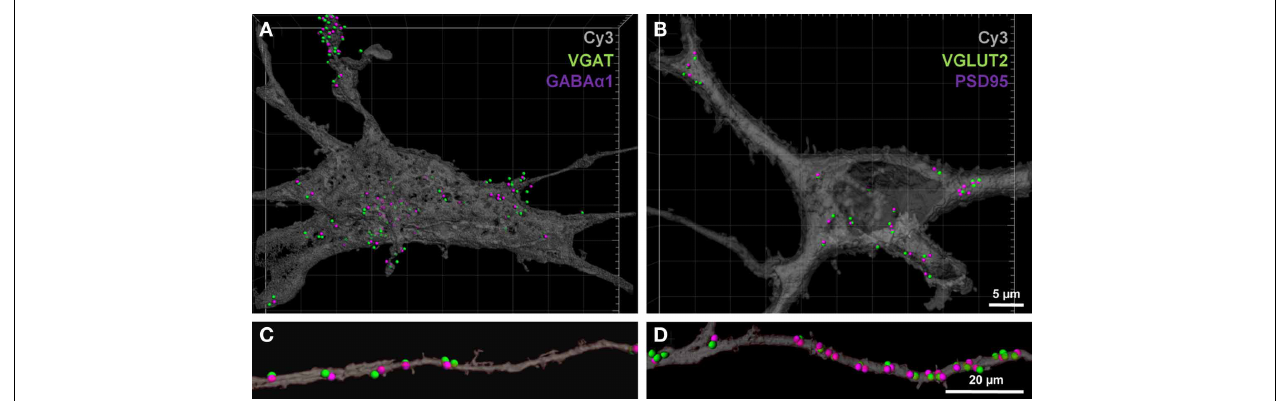
FIGURE 5 | GABAergic and glutamatergic synapses on the somas and distal dendrites of P0 hypoglossal motor neurons. (A) shows a Neurobiotin-filled hypoglossal motor neuron soma and proximal dendrites double-labeled with inhibitory GABAergic synaptic components VGAT (green) and GABA-A receptor subunit α 1 (purple). (B) shows a Neurobiotin-filled hypoglossal motor neuron soma and proximal dendrites double-labeled with excitatory glutamatergic synaptic components VGLUT2 (green) and PSD-95 (purple). Note that the GABAergic synapses are more prevalent than glutamatergic synapses on P0 hypoglossal